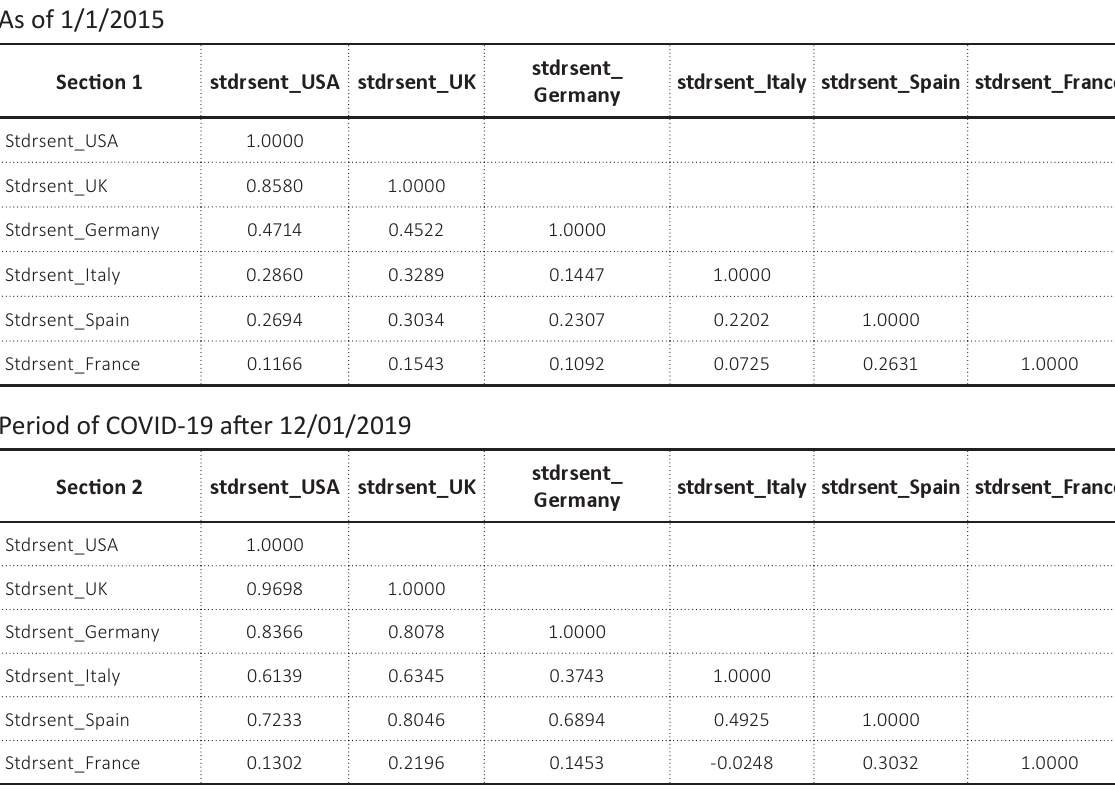
Figure 2. Sentiment for the US and European countries Table 7. Correlation coefficients among irrational behavior measured by the sentiment index duly